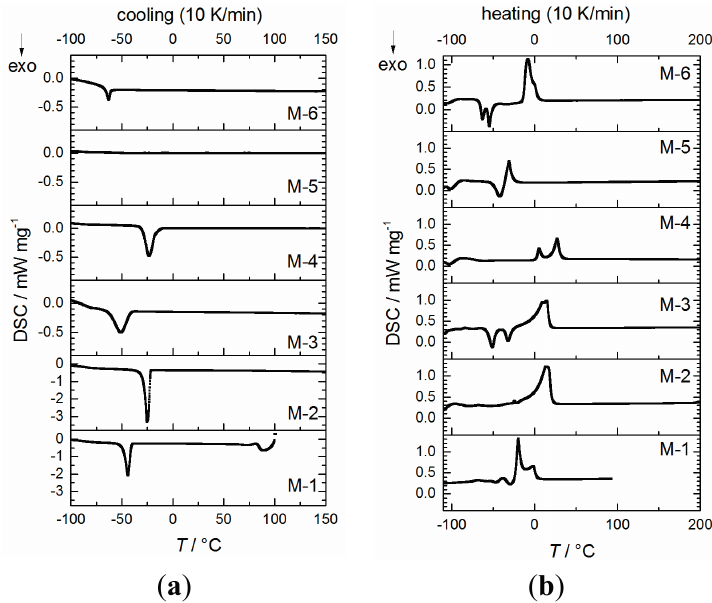
Figure 2. Temperature-dependent values of the density of mixtures M- n ( n = 1–6).